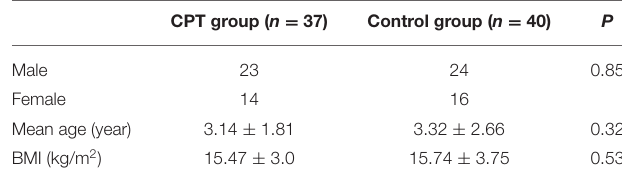
TABLE 1 | Baseline characteristics of CPT patients and